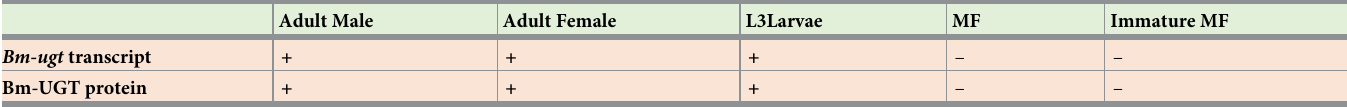
Table 1. Stage specific expression of Bm-UGT. Bm-ugt transcript is expressed in both sexes of the B . malayi adult filaria as well as the L3 larval stage. Protein expression of Bm - UGT is consistent with this transcript profile. Adult